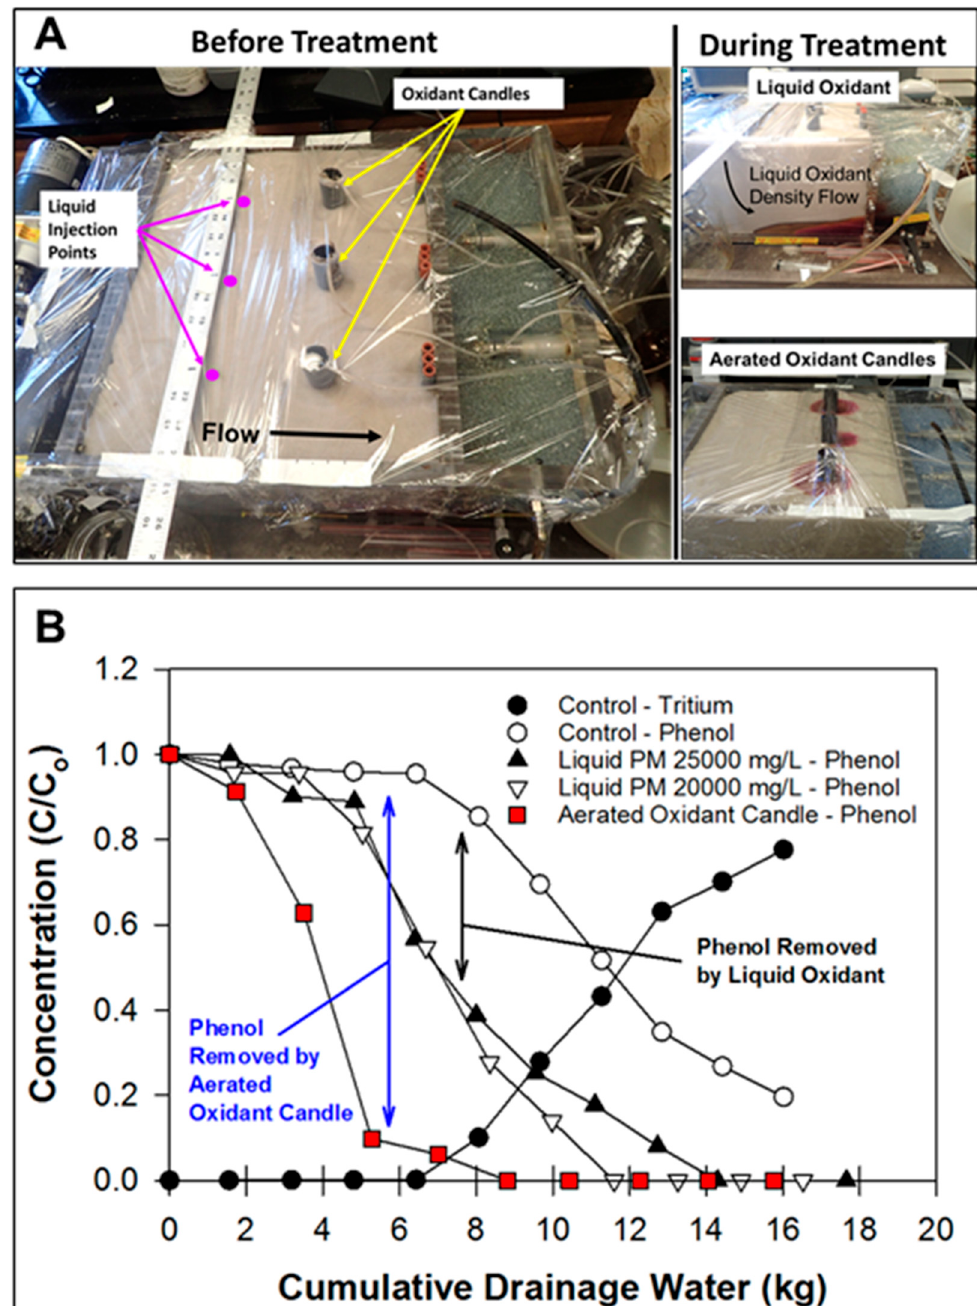
Figure 5. ( A ) Photographs of the flow box used to compare liquid oxidant versus aerated oxidant candles during transport and ( B ) breakthrough curves of 3 H2O and phenol removal during transport experiments. Transport experiments were repeated four times and included the following treatments: control ( 3 H20 only); liquid permanganate (PM) injection (20,000 mg / L); PM injection (25,000 mg / L) and aerated oxidant candles.